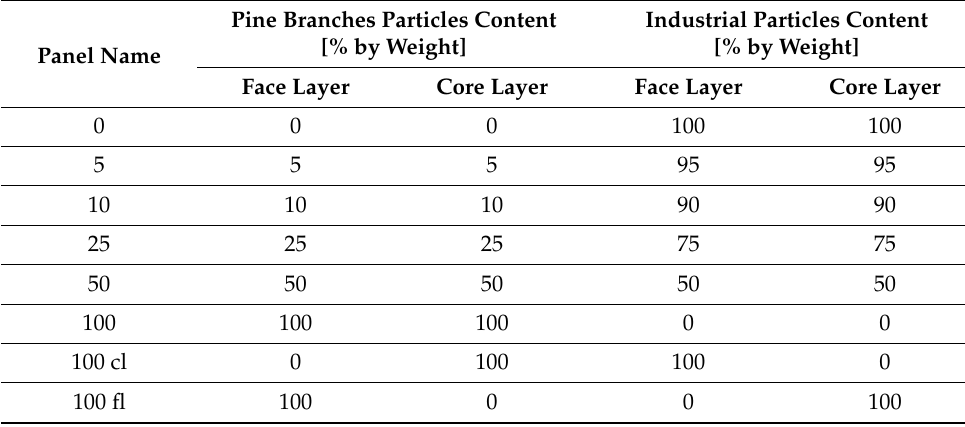
Table 1. Compositions of elaborated